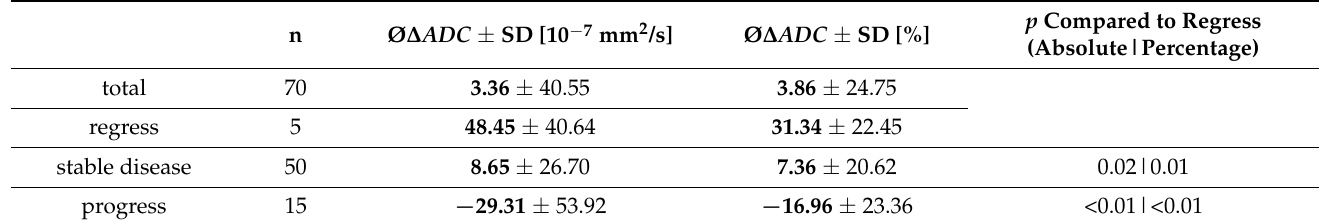
Table 3. Mean ∆ ADC values (bold) in absolute and percentage terms based on the course of the disease. There was a significant ADC increase in tumor regression compared to stable disease and compared to progress (absolute p = 0.02 or <0.01, percentage p = 0.01 or <0.01). n Ø ∆ ADC ± SD [10 − 7 mm 2 /s] Ø ∆ ADC ± SD